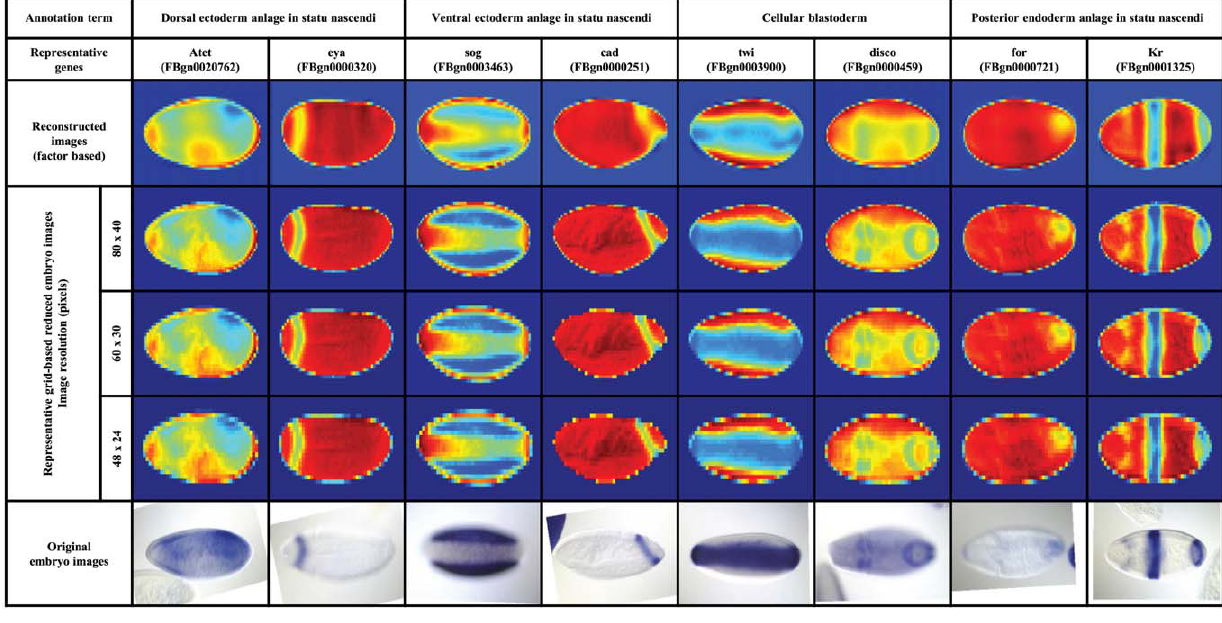
Figure 1. Original, grid-based and reconstructed factor-based images, using the estimated factors and factor loading matrix. Selected annotation terms with the highest number of associated genes; each annotation term is represented by two of its corresponding genes (with the original, the grid-based factor-based embryo images), from the time window of developmental stages 4 { 6 . These examples reveal that images with the same annotation term can show different orientations and quite different patterns, for instance because they are taken during a relatively large temporal window during which expression can change. In the false color display, blue color indicates strong in situ staining while red indicates no